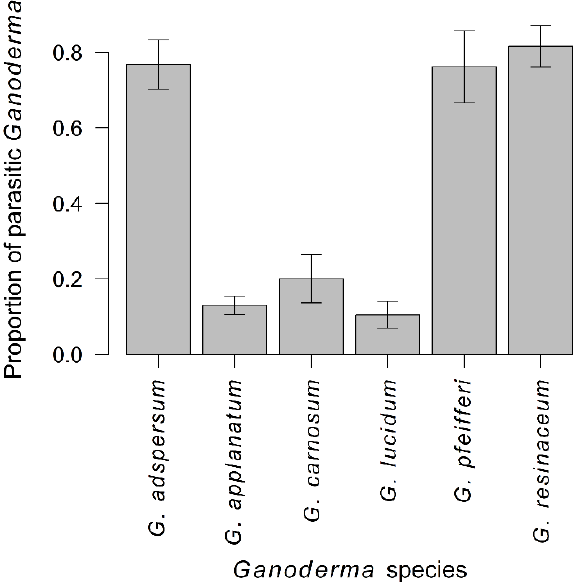
Figure 6. Proportion of parasitic samples in individual Ganoderma species (mean ± SE).